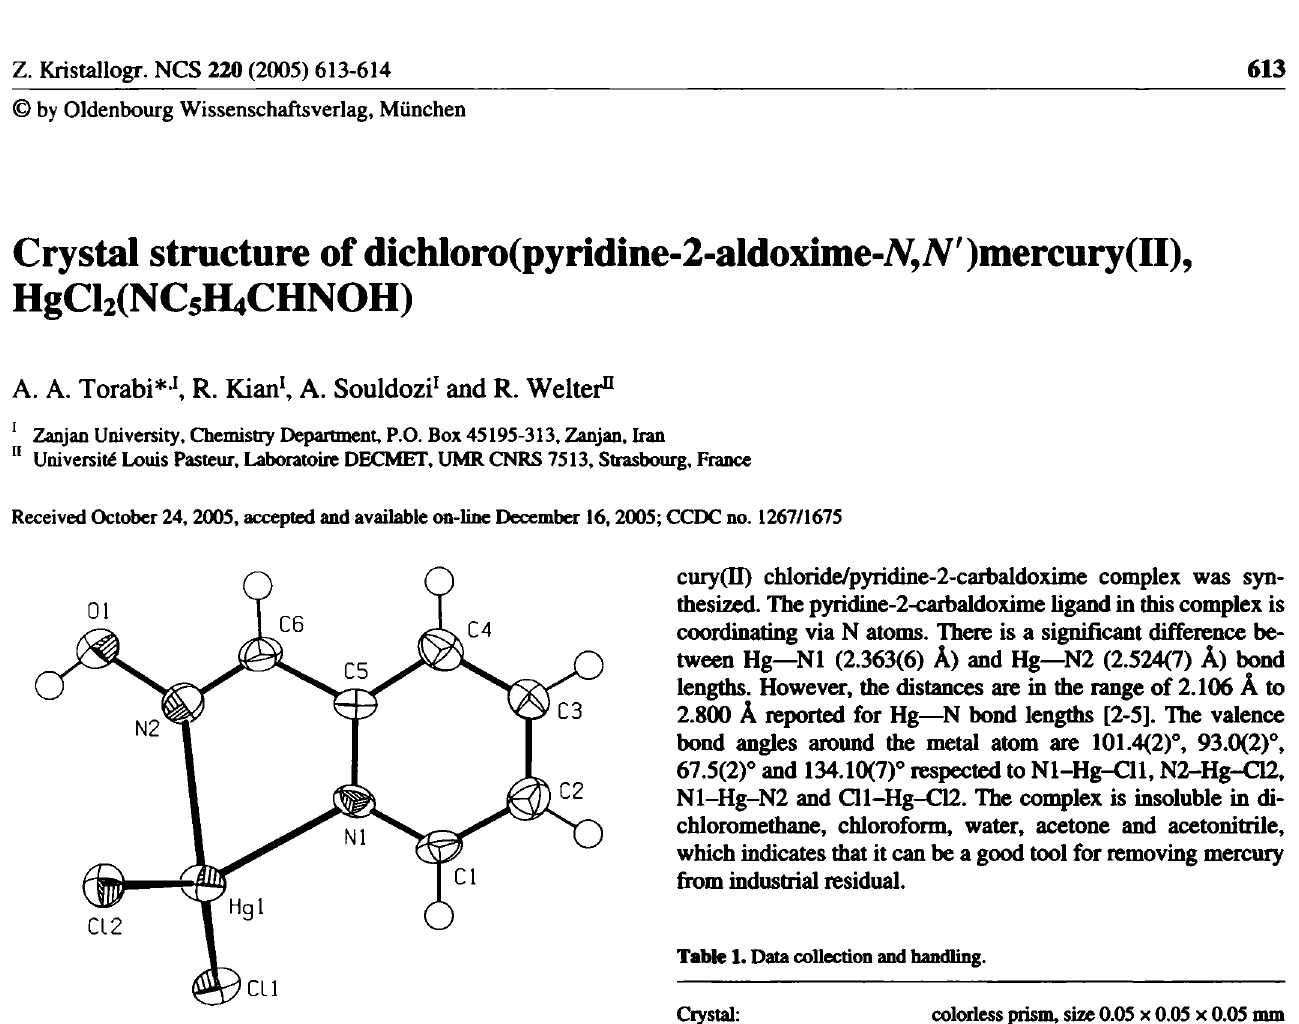
Table 2. Atomic coordinates and displacement parameters (in Ä 2